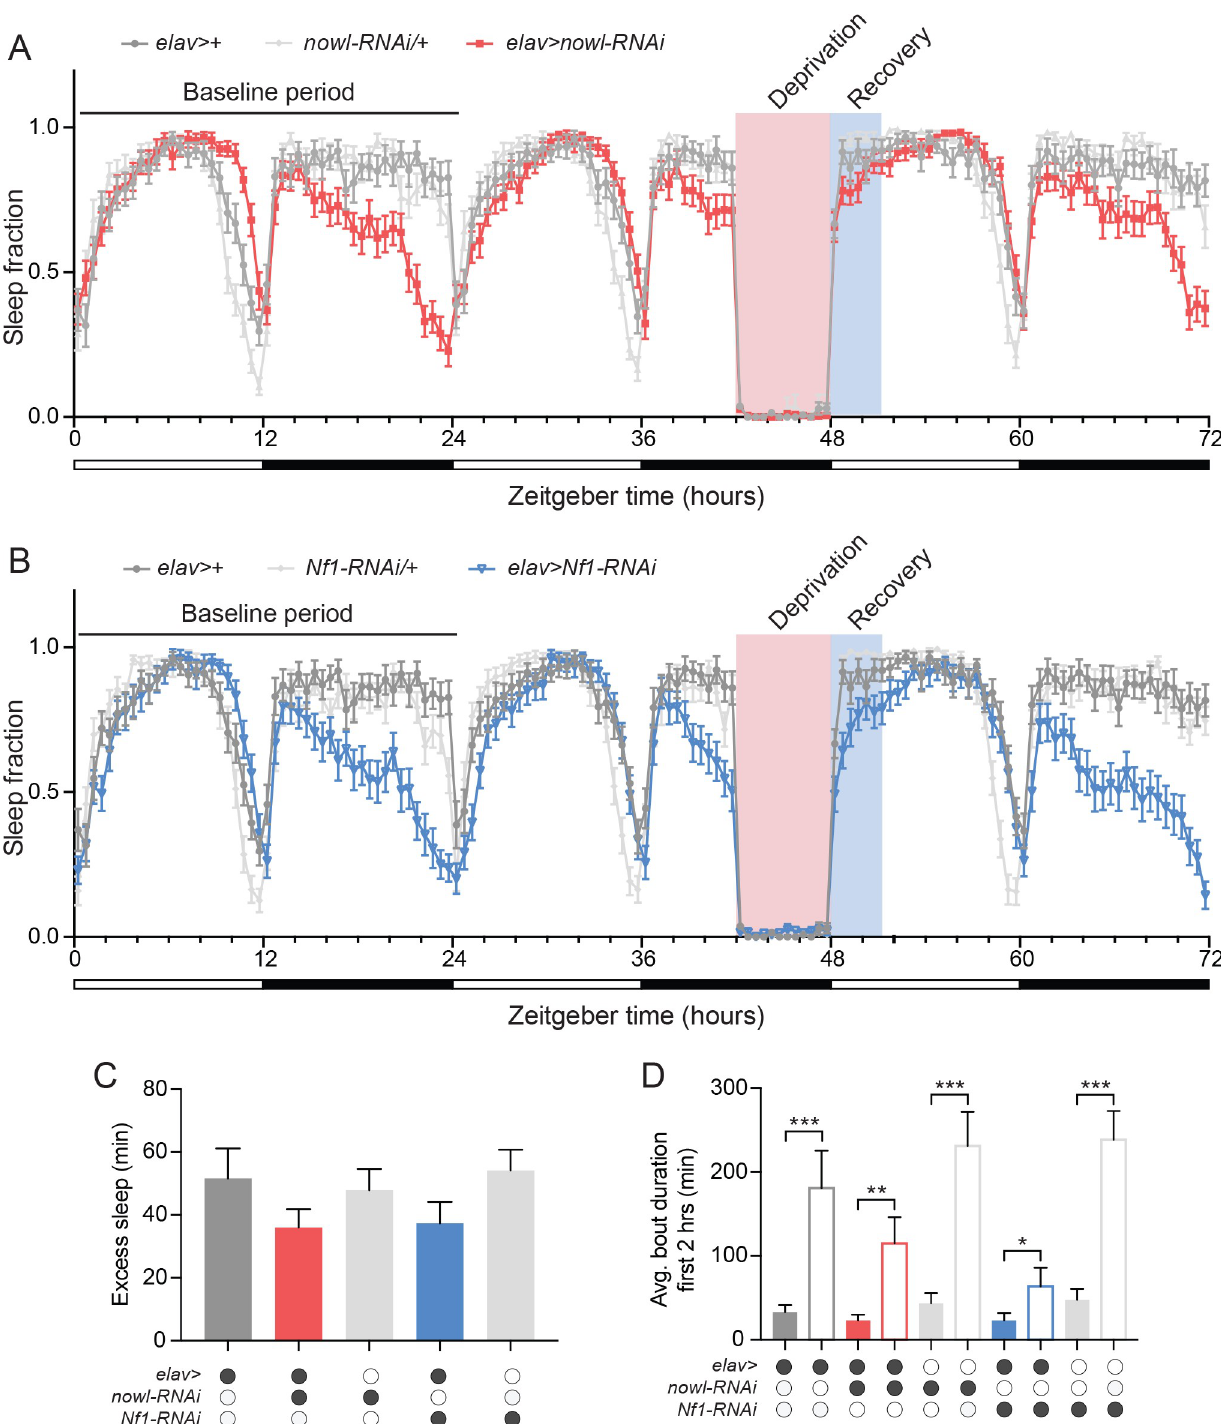
Fig 4. Homeostatic sleep recovery is not affected by neuronal loss of nowl or Nf1 . (A and B) Daily sleep profiles of males under a 12-hour light/dark (white and black bars) cycle in 30-minute intervals for 72 hours for the first (baseline), second (deprivation–flies were subjected to mechanical sleep deprivation for the final 6 hours during night), and third (recovery) days in controls ( elav > + , nowl-RNAi/+ , and Nf1-RNAi/+ ) and animals with neuronal knockdown of nowl or Nf1 ( elav > nowl-RNAi and elav > Nf1-RNAi ). Pink indicates sleep deprivation, while blue indicates recovery periods. (C) Quantification of recovery sleep (excess sleep) during the first 3 hours following sleep deprivation compared to the same period the first baseline day, shows rebound sleep for controls and animals with neuronal knockdown of nowl and Nf1 . No significant differences were observed between genotypes.